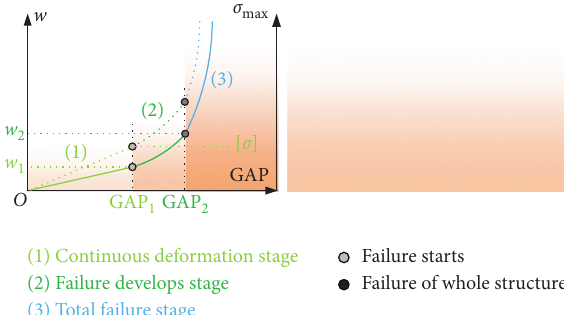
Figure 10: Displacements of environmental structures against GAP parameter (evolution of structural